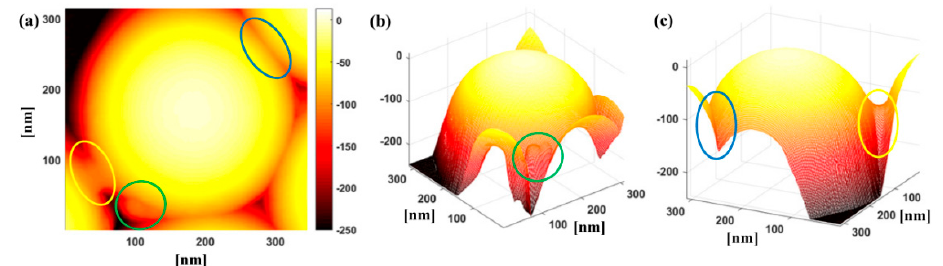
Figure 3. Polymer redistribution occurring during ion irradiation: ( a ) polyhedral-like deformation at the contact area with a neighbouring particle (within the blue line), neck between neighbouring particles (within the yellow line), protrusion due to broken connection (within the green line); ( b ) close-up and three-dimensional view of the protrusion due to broken connection (within the green line); ( c ) close-up and three-dimensional view of the deformation at the contact area with a neighbouring particle (within the blue line) and of a neck between neighbouring particles (within the yellow line).